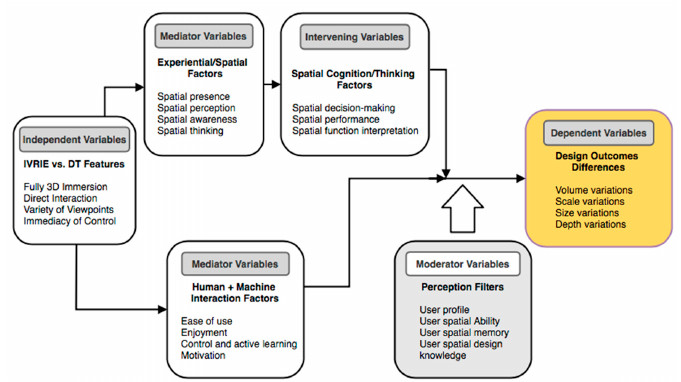
Figure 1. Proposed conceptual model for the experiment design.